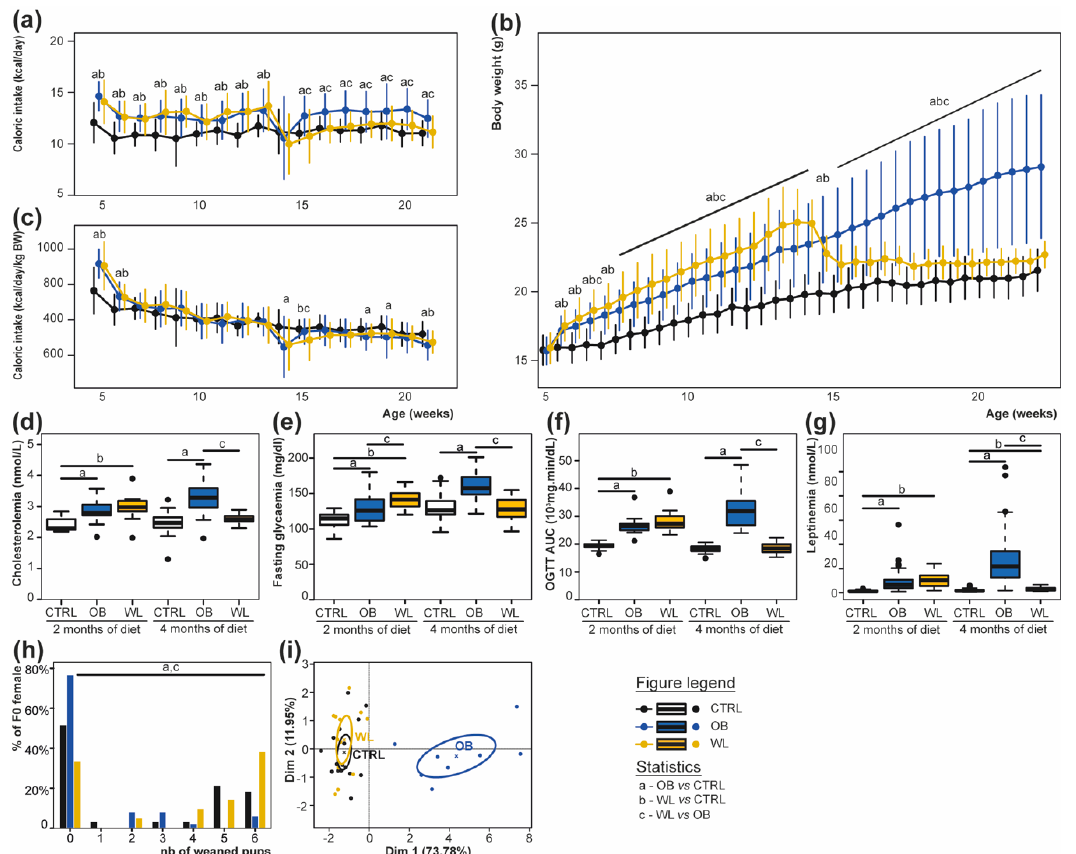
Figure 2. OB dams develop obesity, dyslipidaemia and diabetes and preconceptional WL normalises these parameters. F0 mice were monitored for caloric intake in kcal / day ( a ), body weight ( b ), or kcal / day / kg body weight ( c ), CTRL, n = 20–40; OB, n = 24–72; and WL, n = 12–26, represented as mean ± SD. At 2 and 4 months of preconceptional diet, cholesterolemia ( d ), fasting glycemia ( e ), oral glucose tolerance test ( f ), and leptinemia ( g ) were recorded, CTRL, n = 12–40; OB, n = 11–72; and WL, n = 11–26, represented as Tukey boxplots (dots: outliers). Percentage of weaned pups per litter is indicated in ( h ), CTRL, n = 33; OB, n = 51; and WL, n = 21. A Principal Component Analysis on body weight and organ relative weights at sacrifice shows a separation of OB from CTRL and WL dams on dimension 1 ( i ), CTRL n = 16; OB, n = 8; and WL, n =